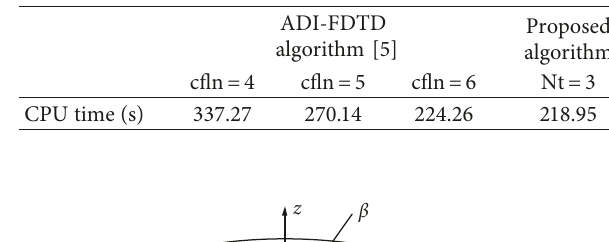
Table 1: Simulation results of the two algorithms in the first example.